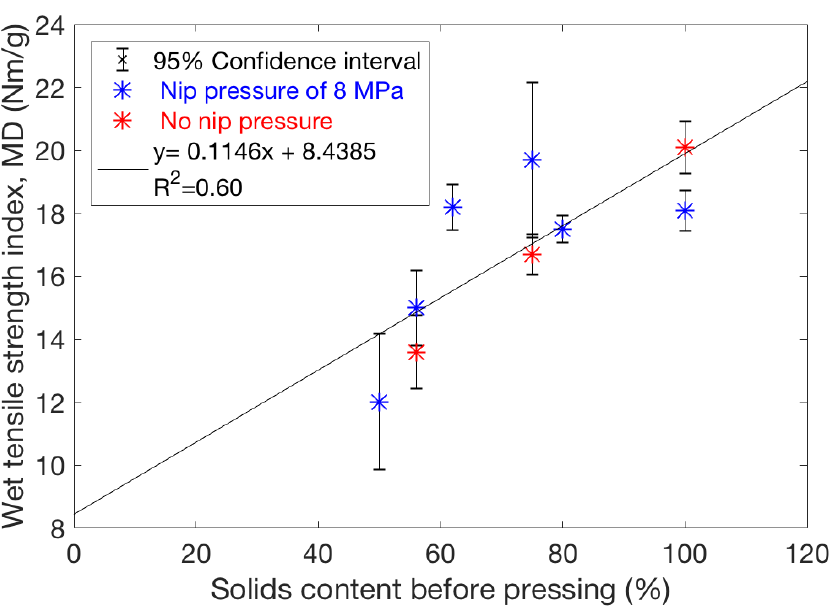
Figure 8. Wet tensile strength index of TMP sheets improves when the pressing is done on a dried web. Here the initial solids content is varied for the constant pressing temperature of 230 °C, keeping other process conditions fixed for all trial points. The points represent an average of 10 data points and their 95% confidence intervals. The applied pressure is 8 MPa for the blue markers, and 0 MPa for the red markers. Wet tensile strength seems not to be very dependent on pressure or density. The applied pressure (0.15 MPa over 23 s) exerted by the steel-belt after the pressing nip seems sufficient to improve wet tensile strength to the same level as when using the 8 MPa nip